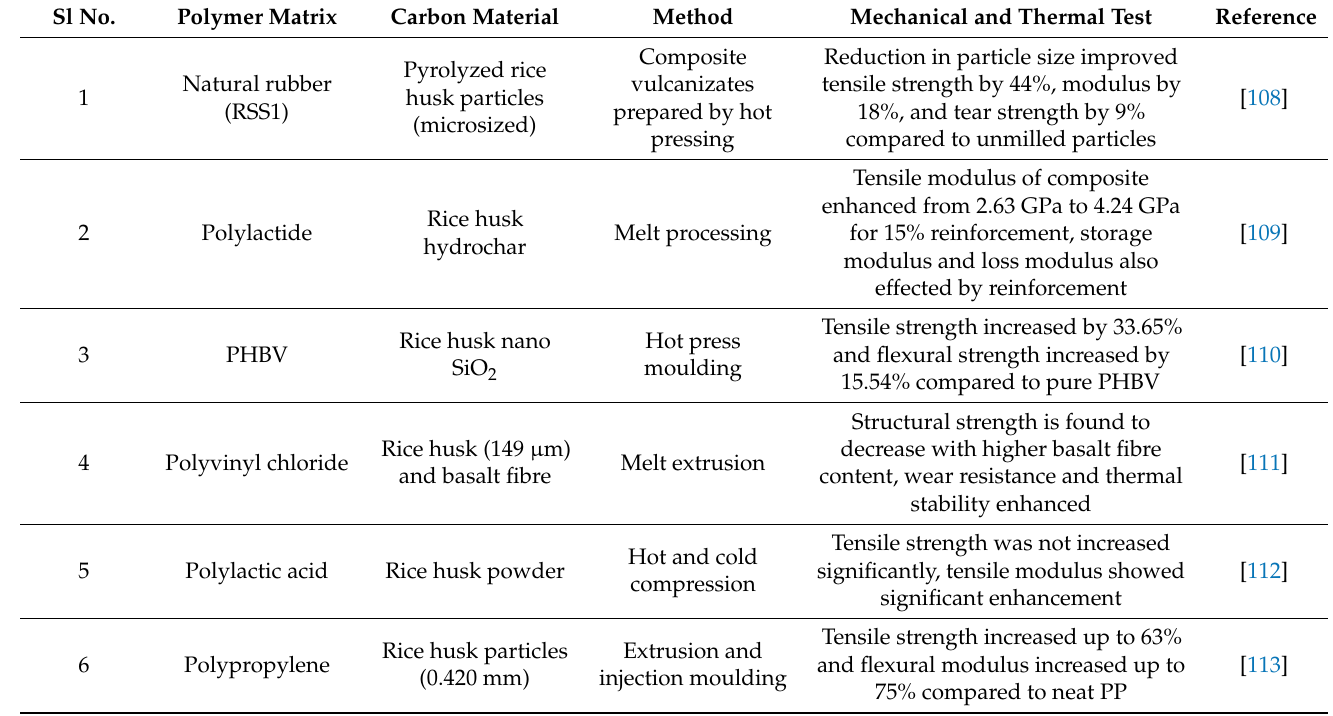
Table 8. Synthesis characterization of polymer nanocomposites from rice husk. Sl No.